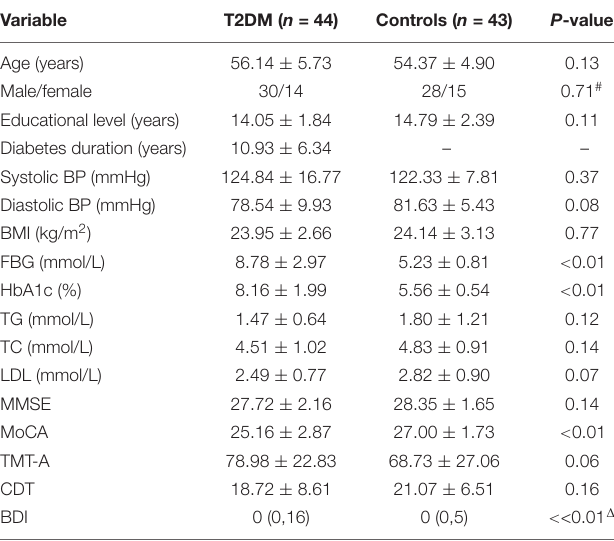
TABLE 1 | Demographic, clinical, and cognitive data of the patients with type 2 diabetes mellitus (T2DM) and the healthy controls (HCs).